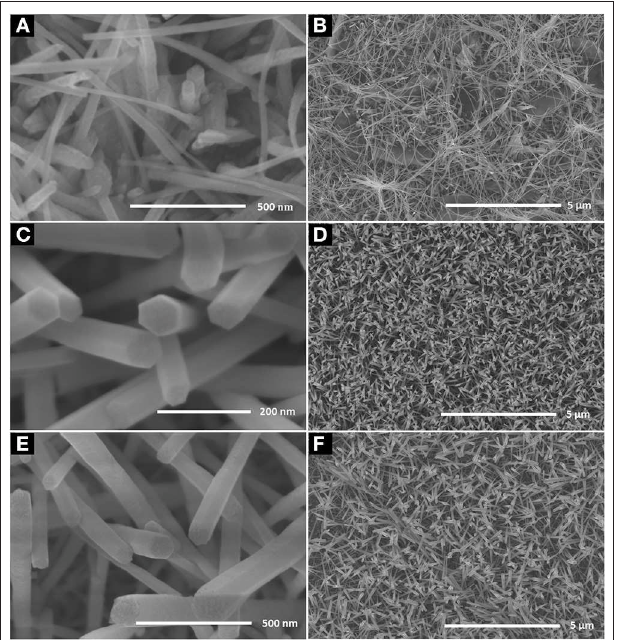
FIGURE 1 | SEM images of the ZnO nanorod arrays coated on glass substrate with different reaction time (A) 2h, (C) 4h, and (E) 6h; (B,D,F) are as-prepared large area ZnO nanorod arrays of the corresponding samples.